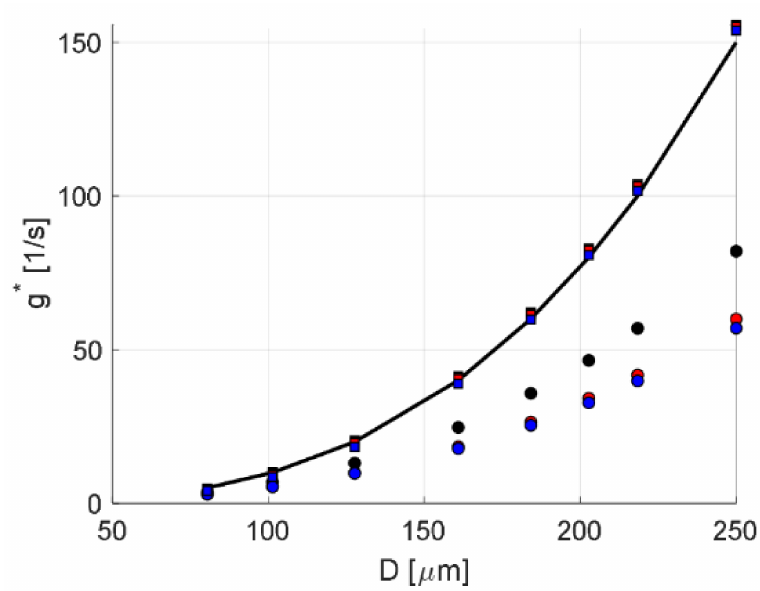
Figure 10. Case B: Inhomogeneous flow but homogenous breakup frequency. Set breakup frequency (line) compared to global estimate (circles: uncorrected, squares: RTD-corrected) at different drop diameters, D . Results from three flow conditions: U g = 1.5 m/s ( black ), U g = 3.0 m/s ( red ) and U g = 6.0 m/s ( blue